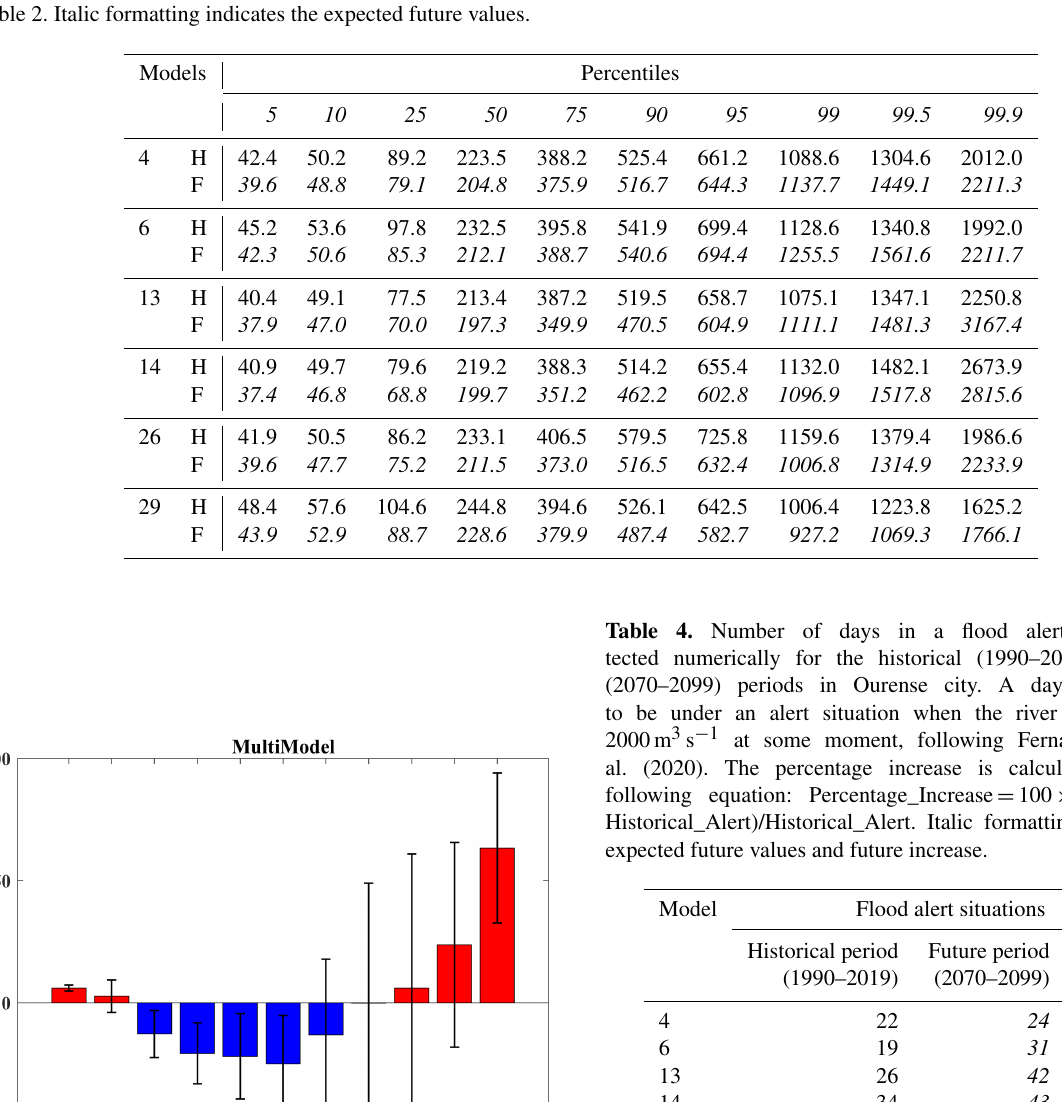
Table 3. Historical (H) and future (F) percentile values of river discharge (m 3 s − 1 ) at Ourense city simulated for the RCMs marked in bold in Table 2. Italic formatting indicates the expected future values.